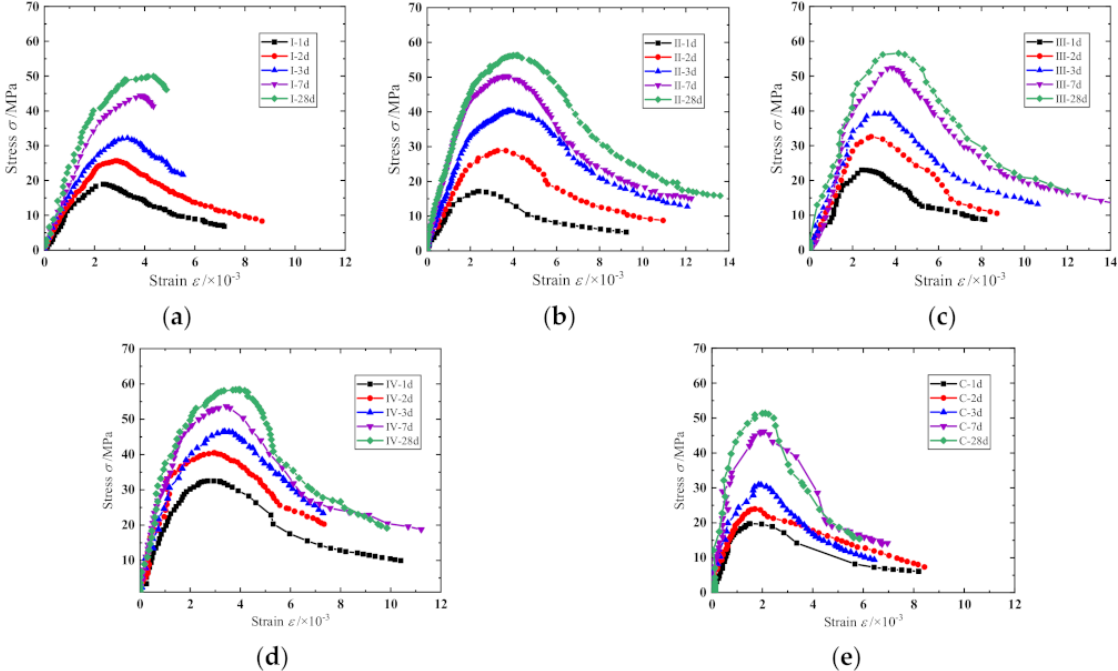
Figure 5. Typical compressive stress–strain curves of ( a ) CGM − 380; ( b ) CGM − 340; ( c ) CGM − 300; ( d ) CGM − 270; and ( e ) concrete